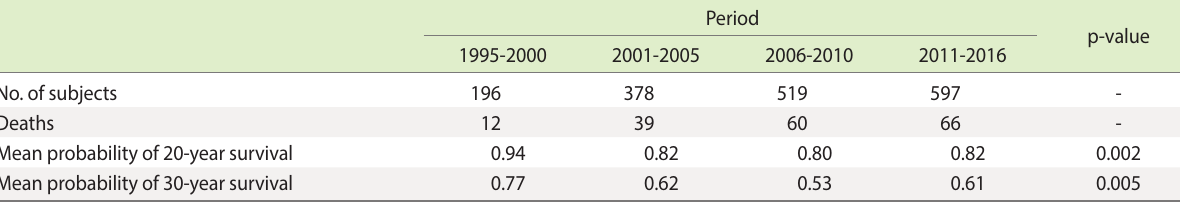
Table 1. Trends in the 20- and 30-year survival rates of thalassemia major patients by period analysis, Iran,